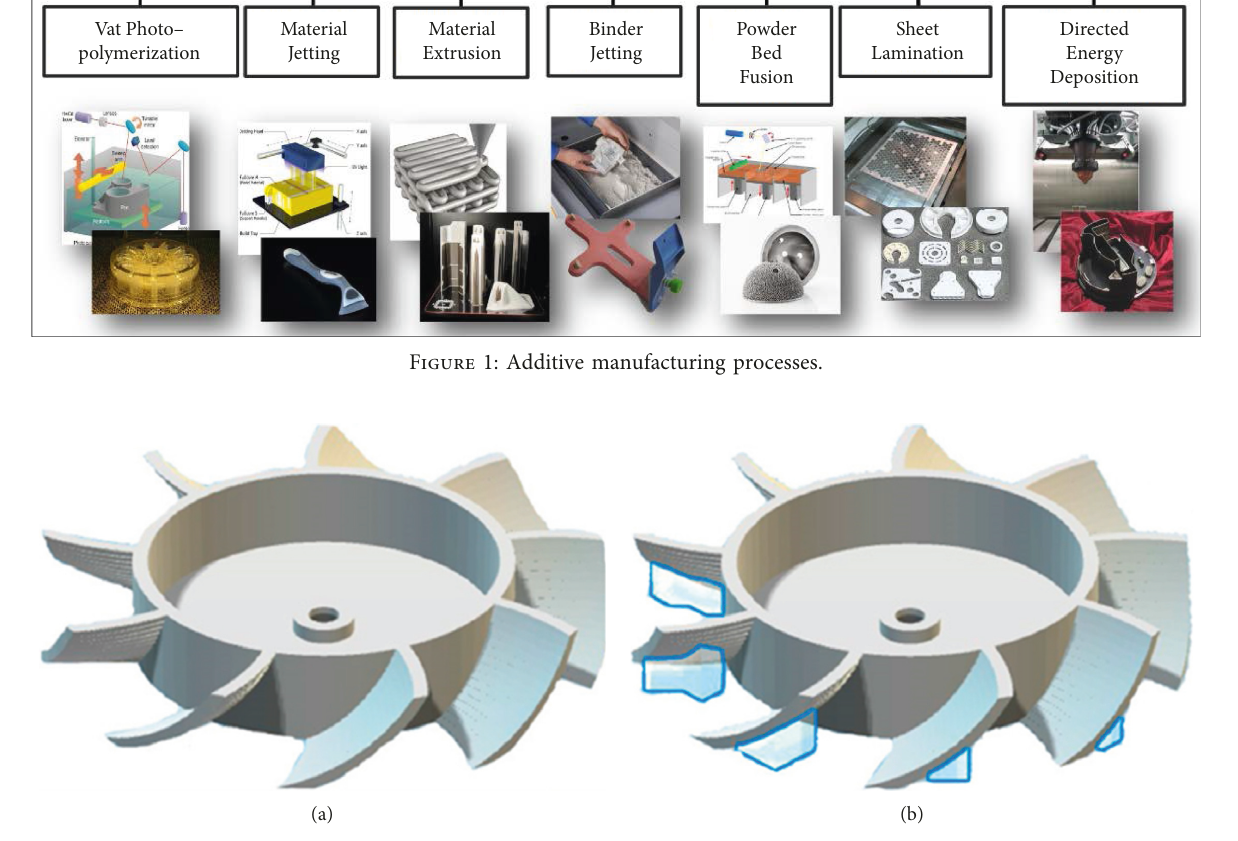
Figure 2: (a) Engineering part. (b) Features need support [11]. Table 1: Some AM technologies their need for support structures